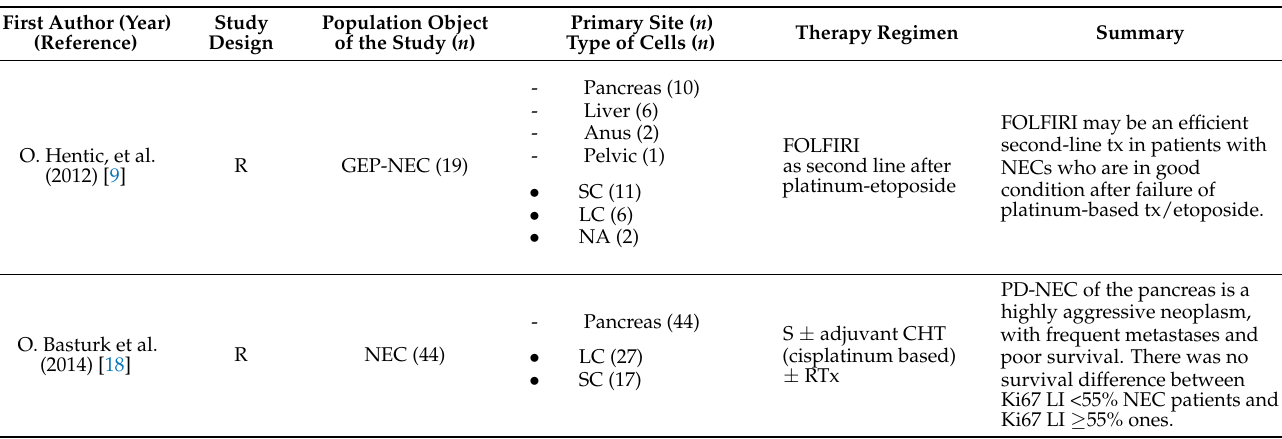
Table 1. Characteristics of the included studies.